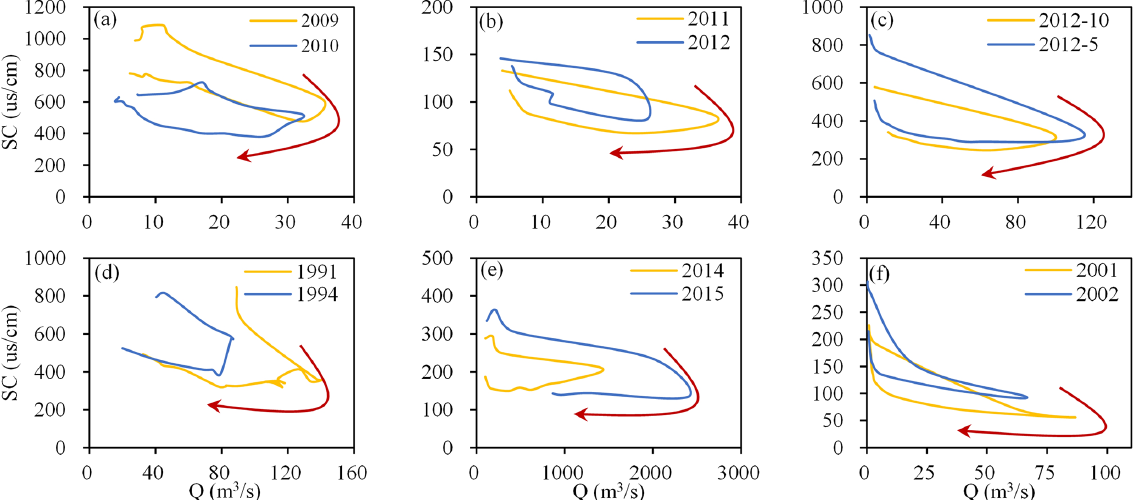
Figure 6. Clockwise hysteresis loops between conductivity and streamflow during flood events evident in the streamflow sequences of six United States Geological Survey (USGS) stations. (a) Station 02298202; (b) station 02207120; (c) station 03106000; (d) station 06089000; (e) station 03072655; (f) station 08068275. The arrows reflect the direction of